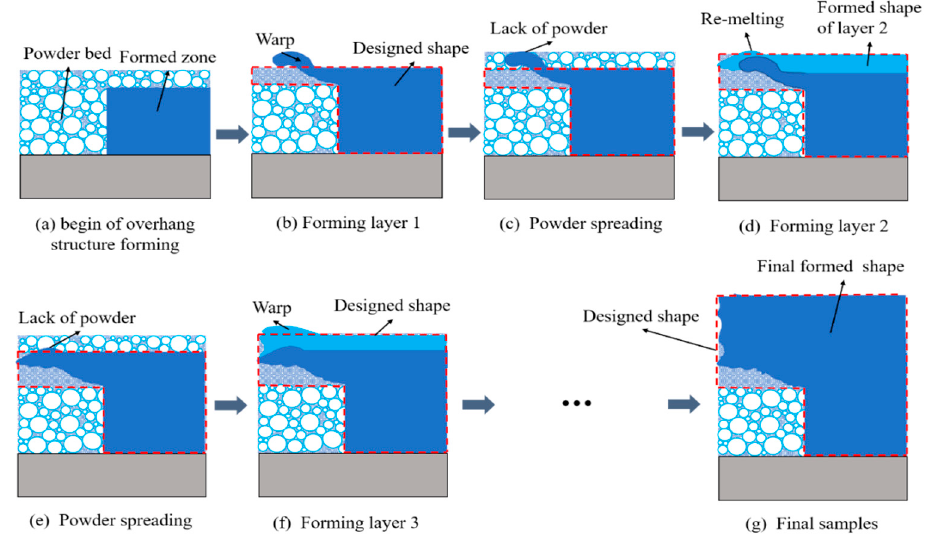
Figure 13. Illustration of overhang structure warping deformation process.